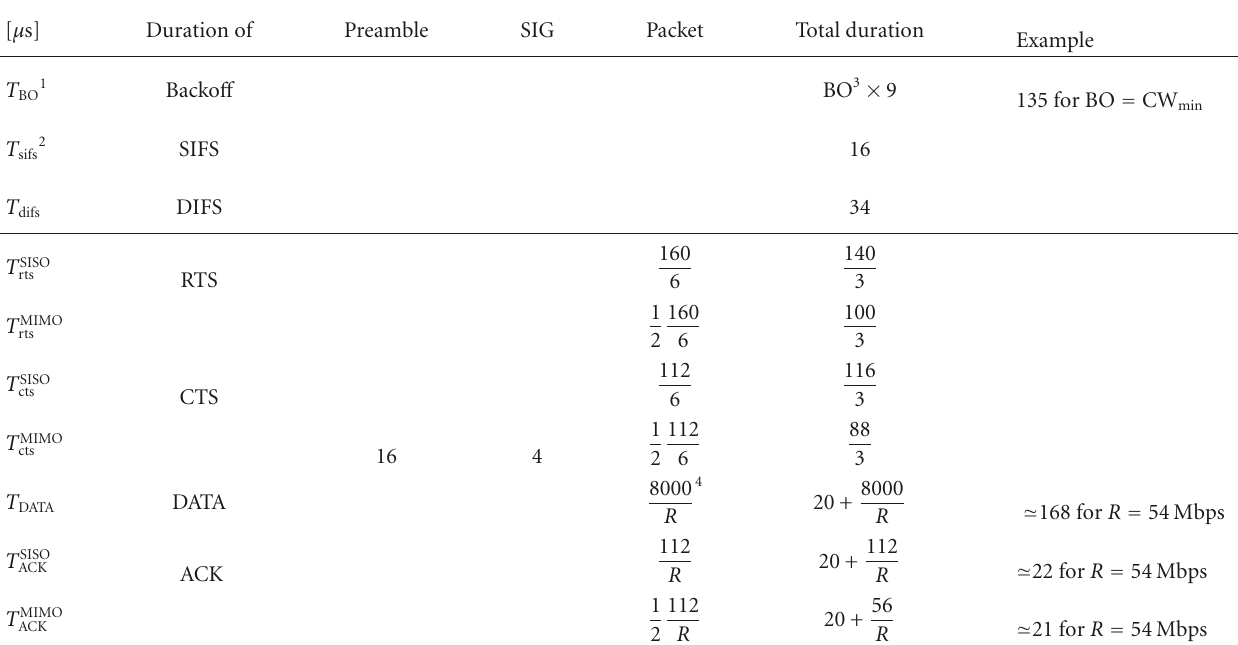
Table 2: Important time duration of (nonslotted/slotted) CSMA/CA (unit: μs